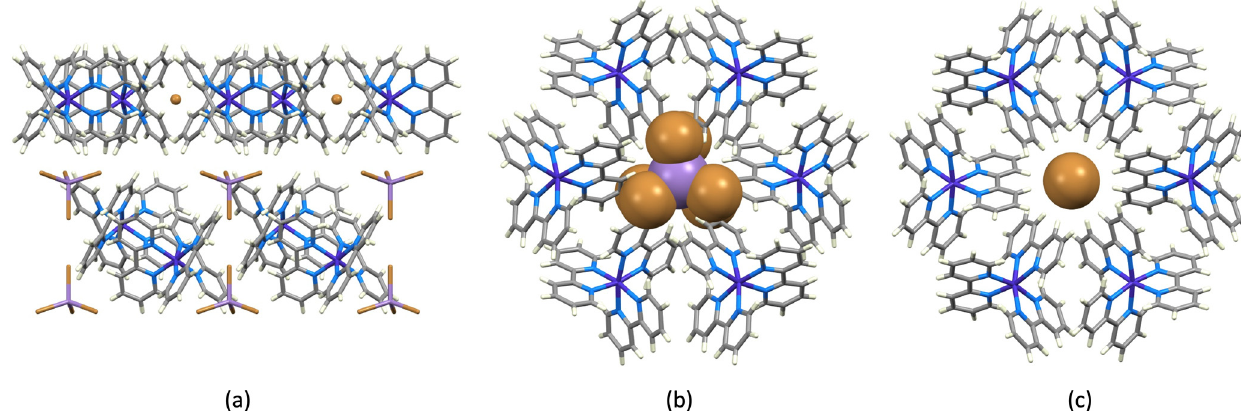
Figure 14. The structure of [Co I (bpy) 3 ] 3 [Co II (bpy) 3 ][MnBr 4 ] 2 Br . 2DMF (refcode SABGOV [85]). ( a ) Parts of adjacent homochiral 2D-sheets viewed down the crystallographic a -axis; the Br – ions in the top layer are shown in ball-and-stick representation for clarity. All [MnBr 4 ] 2– -containing sheets have